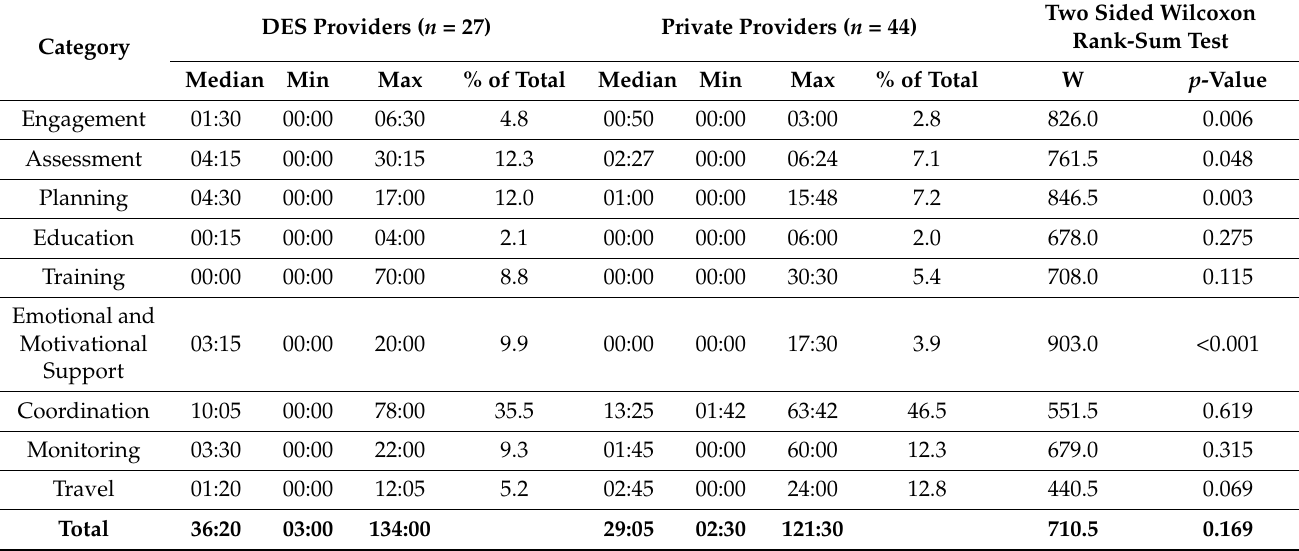
Table 5. Service actions by provider